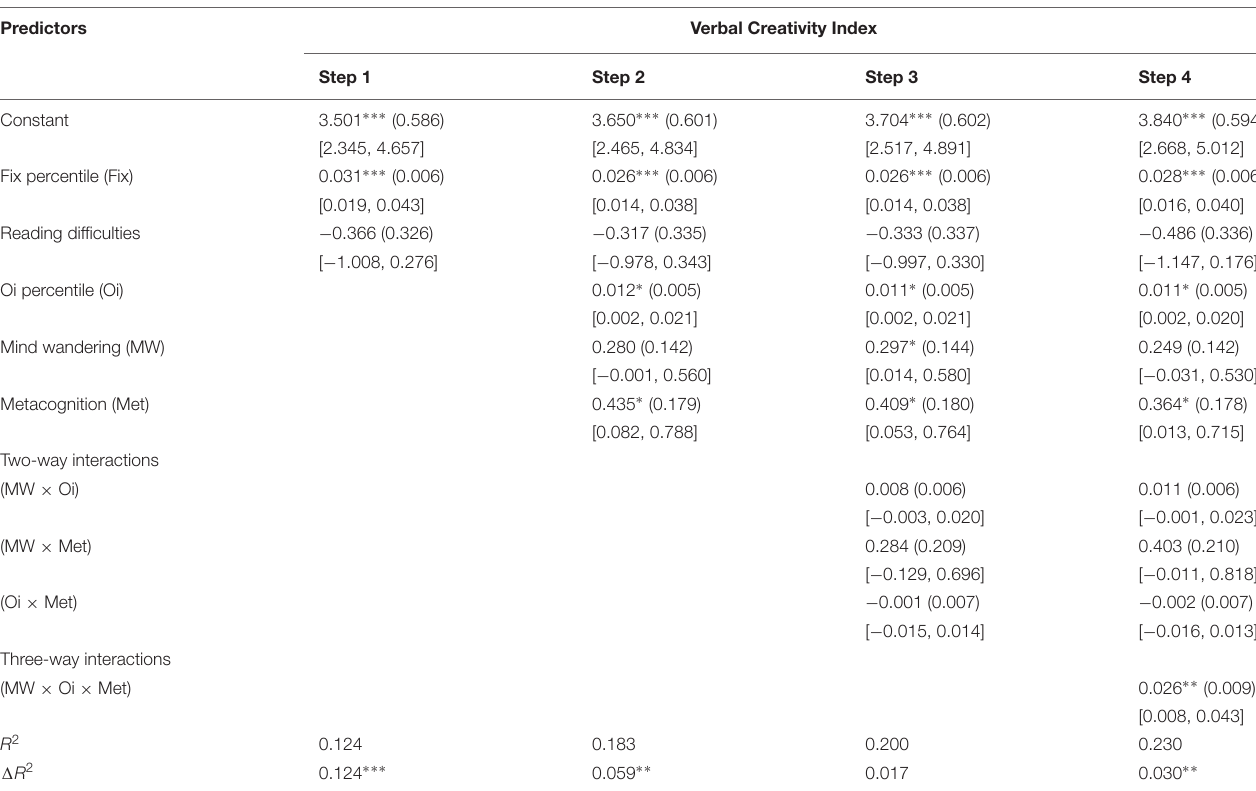
TABLE 2 | Mind wandering effect on creativity moderated by attentional capacity and metacognition.